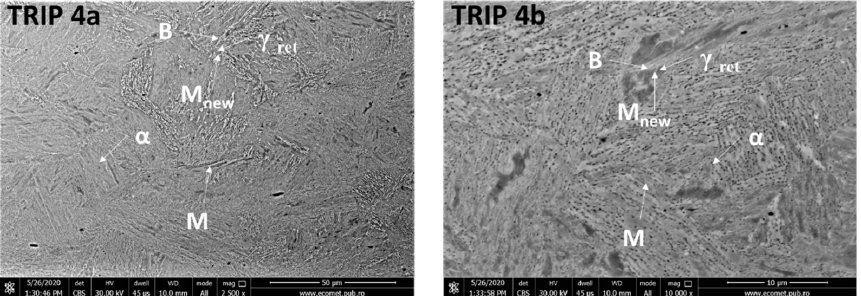
Figure 8. BSE microstructures of TRIP 4 steel (( a , b ) at different magnifications) after impact bending